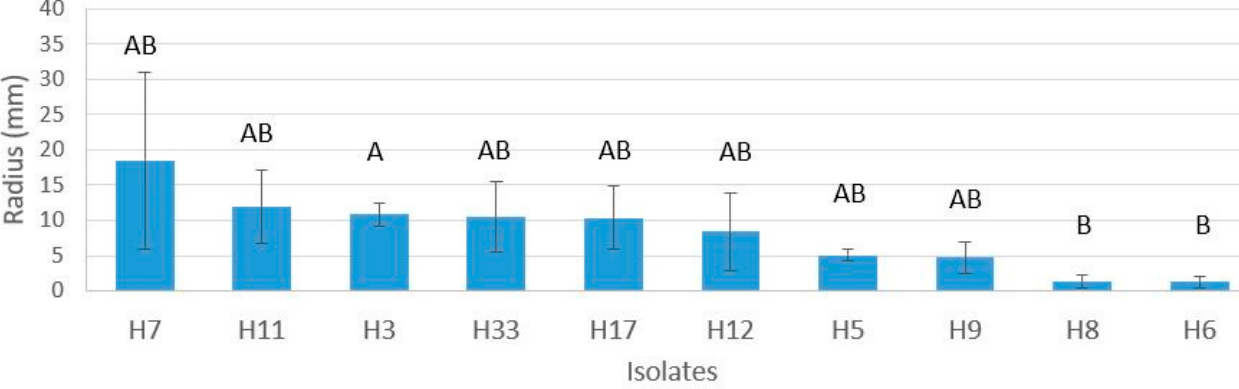
Figure 5. Lesion radius 4 days post-inoculation. Relative virulence of Phytophthora palmivora isolates causing disease on Theobroma cacao in Hawaii was quantified as lesion radii four days post-inoculation. Isolates sharing the same letters above the bars are not significantly different ( p ≤ 0.05). Untransformed means are displayed in the figure, and bars represent standard errors.